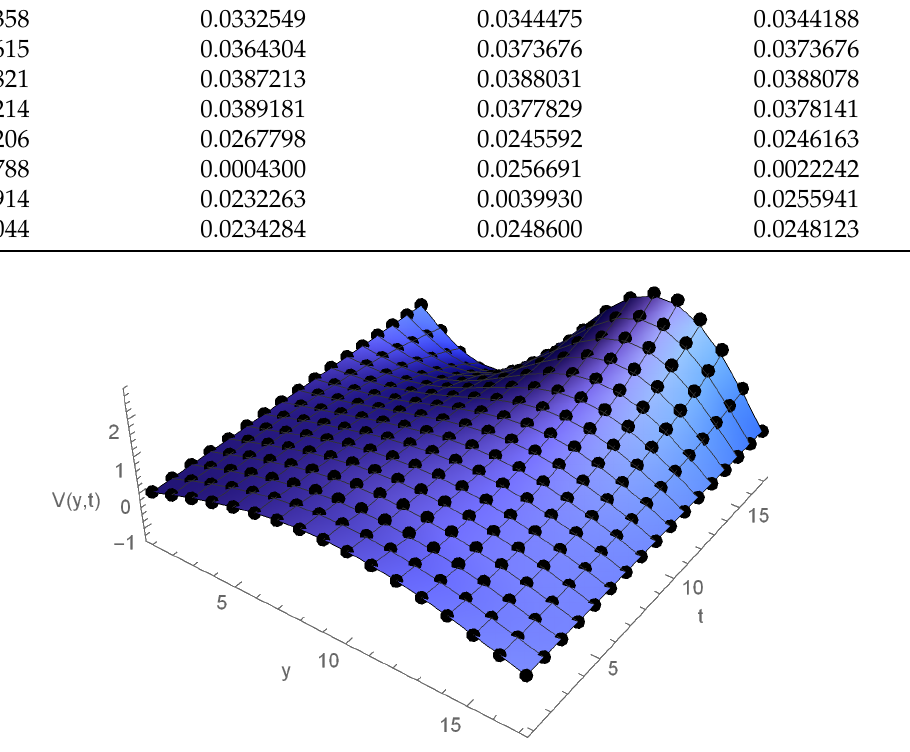
Figure 4 . A Comparison plot (dots show the exact solution while the solid lines illustrate approxi- mated solution) of Example 2 at γ = 0.5 and α = 0.15.